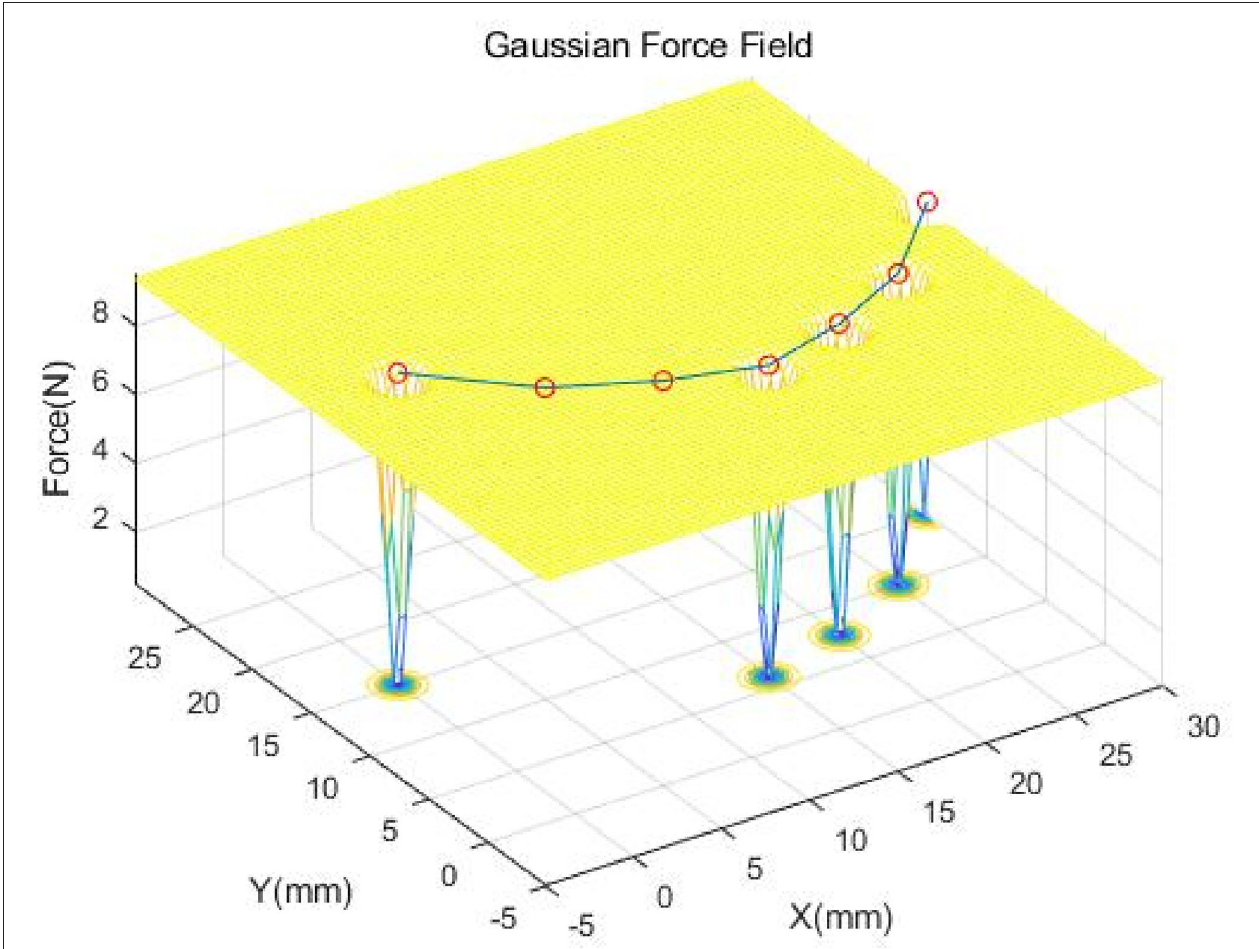
FIGURE 3 | This is a Gaussian force field example of D=2 with a simplified physical model and two nodes occluded. The red circles represent the nodes of the physical model. The motion of the physical model is constrained by the force field described by the